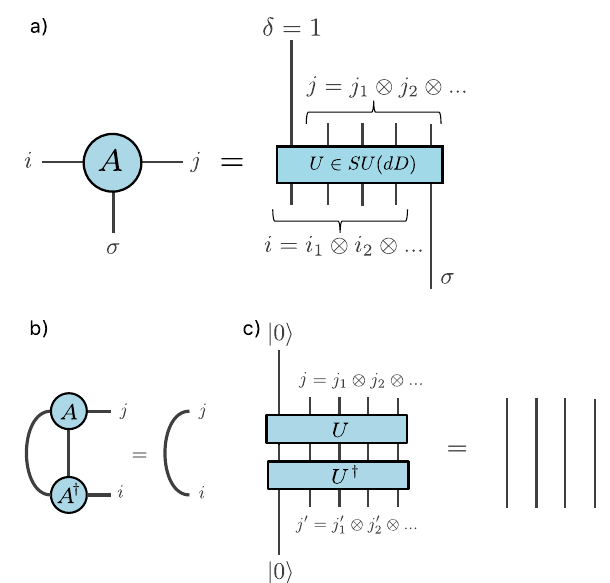
Fig. 6 Translation between MPS quantum circuits. a The transla- tion of an MPS tensor to a quantum circuit. The auxilliary index of D qubits. b The canonical bond order D is created from N ¼ log 2 form implies that the effect of contracting the MPS to the left is trivial. c With our mapping of the MPS to a quantum circuit, the unitarity of U automatically puts the tensor in left canonical